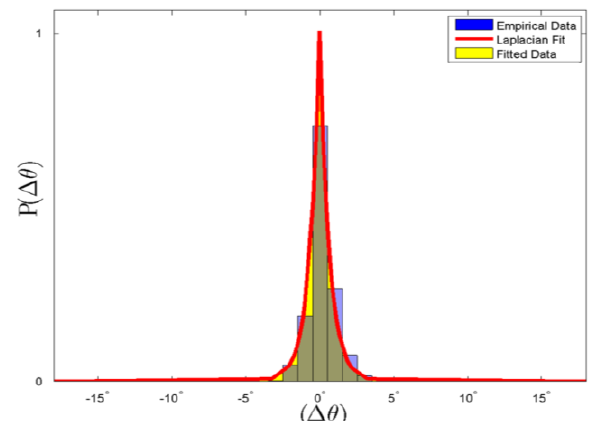
Figure 8. Error model for Orientation Residual Scoring